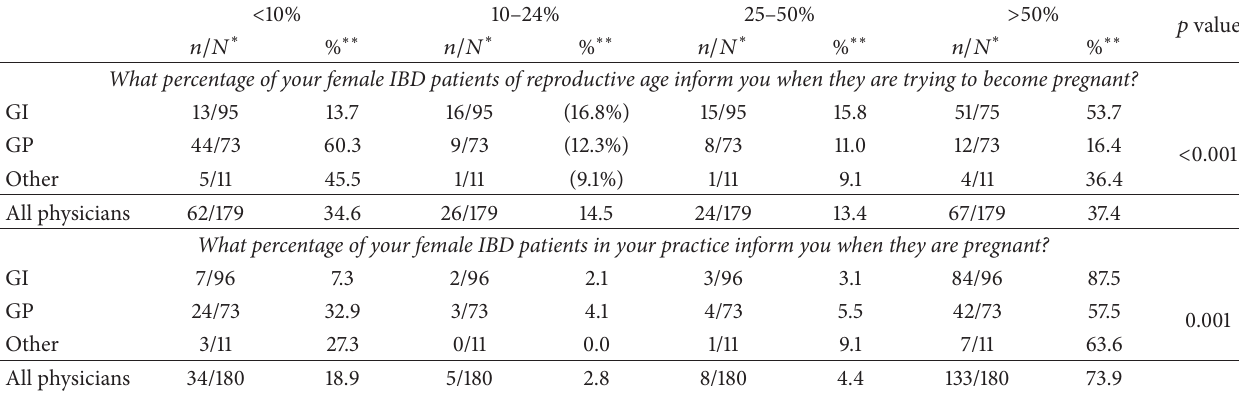
Table 2: Physician perception of the percentage of their female IBD patients reporting pregnancy or pregnancy